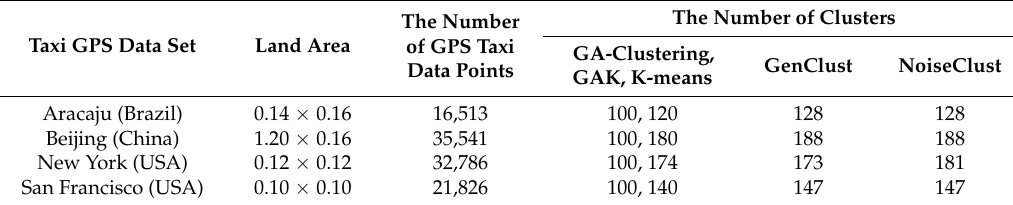
Table 1. The experimental data sets of taxi Global Positioning System (GPS) data.